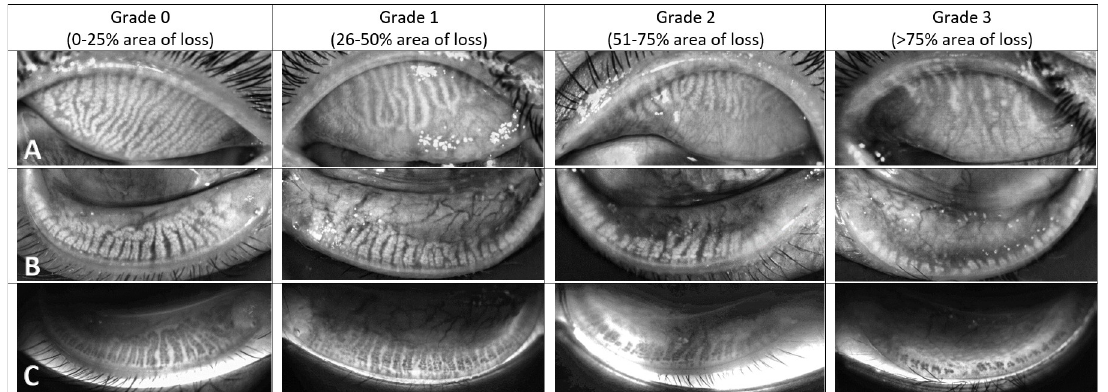
Fig 1. The Meibograde grading system: subjective grading of meibomian gland loss. Row A: Dynamic illumination mode (Reflect infrared) of upper lids; Row B: Dynamic illumination mode (Reflect infrared) of lower lids; Row C: Adaptive transillumination mode (Trans infrared) of lower